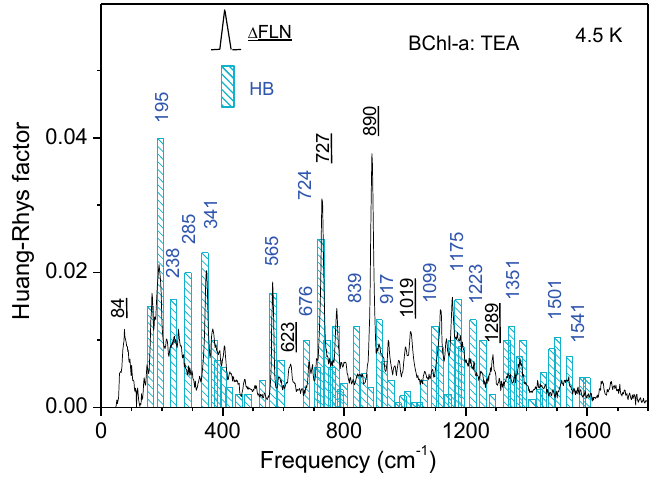
Fig. 6. Comparison of the 6CO BChl-a mode structures related to the Q and SHB (turquoise histogram) [123] methods. The numbers indicate the main vibrational frequencies in wavenumbers. Reprinted with permission from [67]. Copyright 2011 AIP